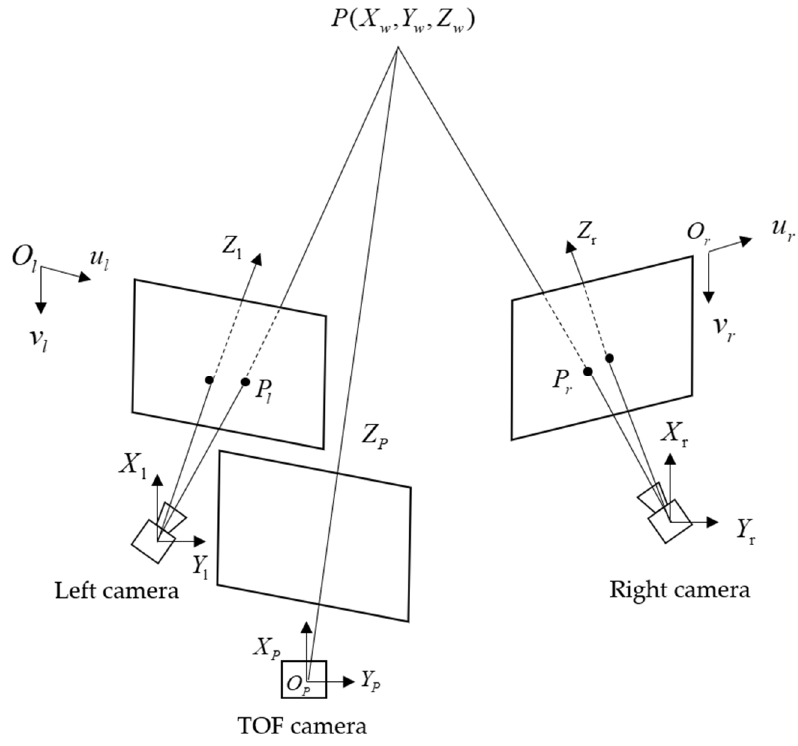
Figure 2. Schematic diagram of the pose measurement system.